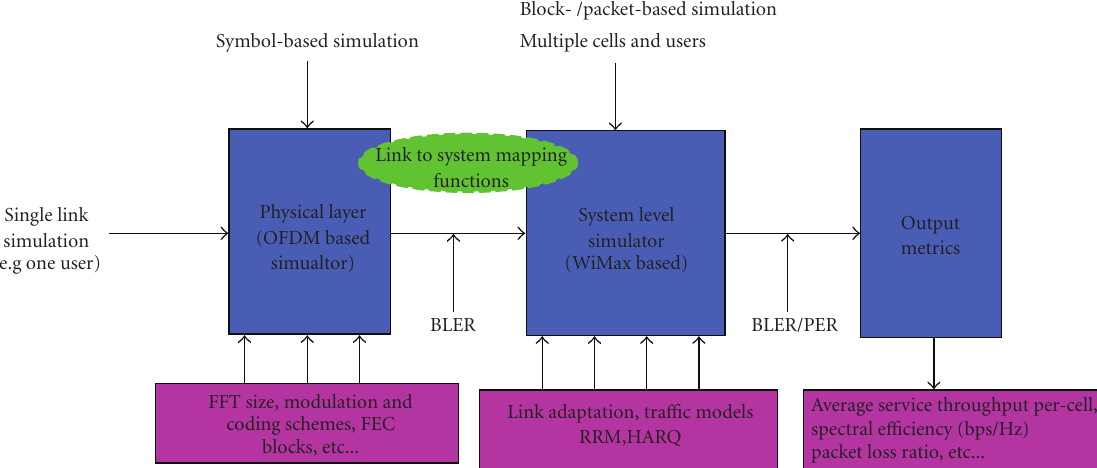
Figure 1: Network simulator.